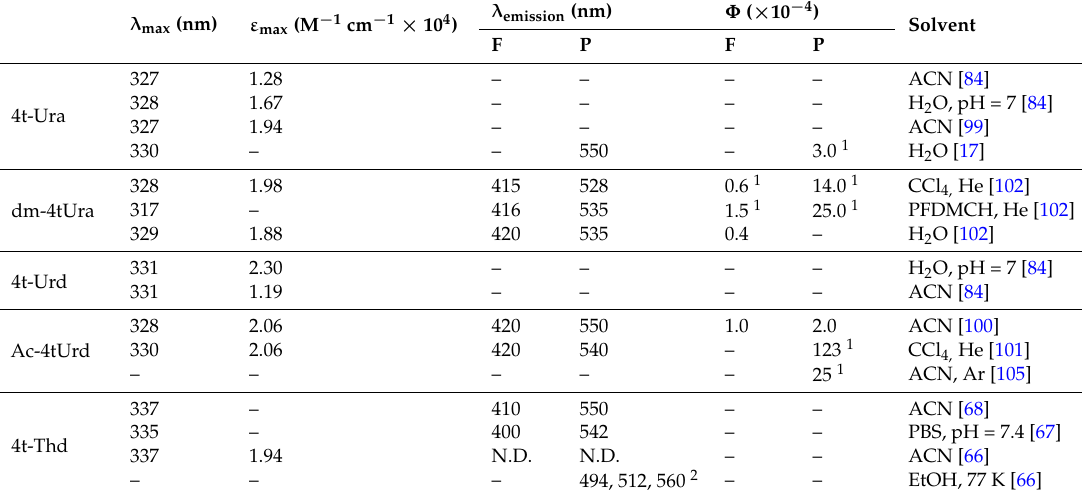
Table 6. Steady-state absorption and emission properties of 4-thiopyrimidine derivatives at room temperature unless otherwise indicated. F: Fluorescence; P: Phosphorescence; N.D.: Not detected,